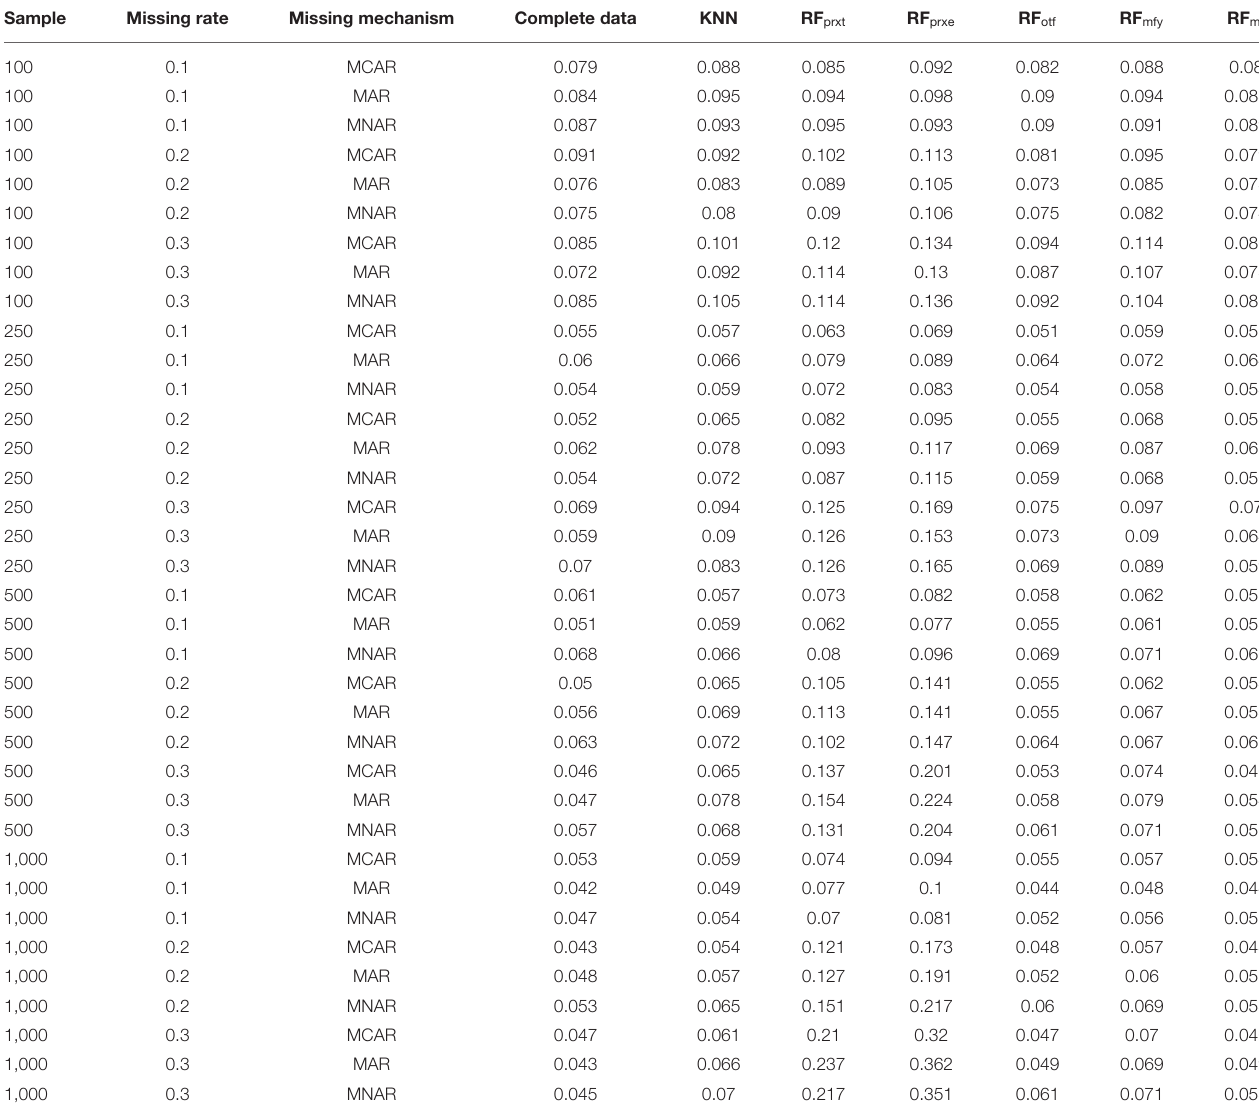
TABLE 2 | The type-I error of the Cox model.